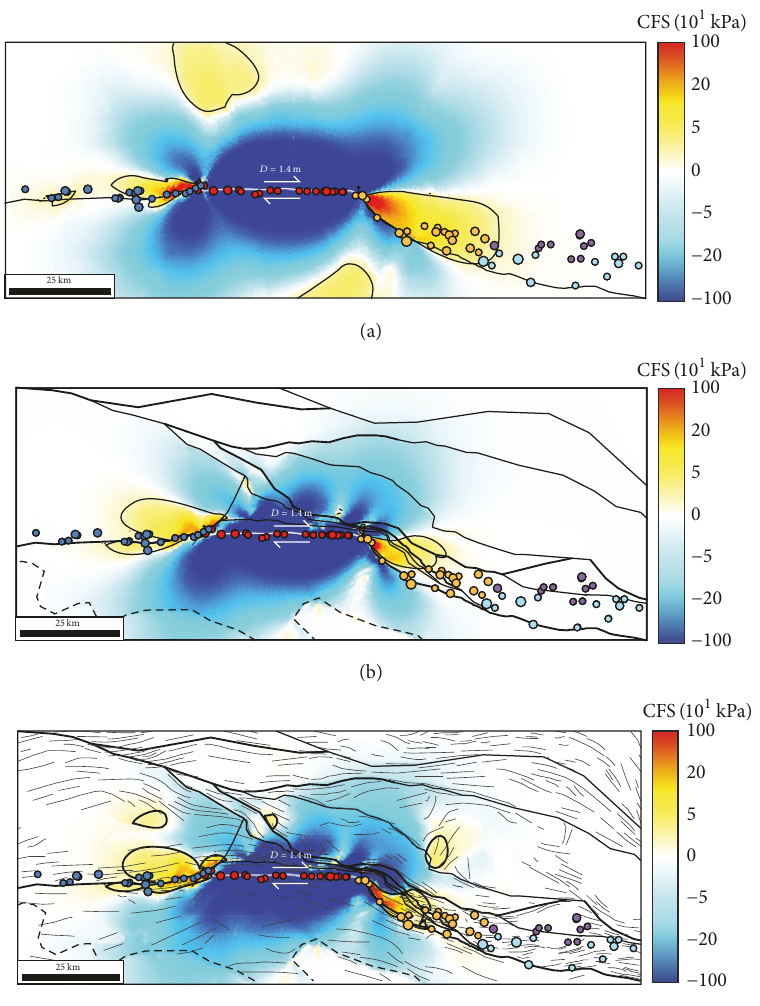
Figure 4: Coulomb static stress changes following the rupture of the Joannes Segment. (a) Model 1.a includes only the Cadillac-Larder Lake Fault. (b) Model 1.b includes rheological contrasts and the structural framework. (c) Model 1.c same as 1.b but with foliation fabric added as low-strength primary failing planes. Positive lobe boundaries are set at 30 kPa. The circles indicate deposits’ locations, with colours reflecting the distinct goldfields as explained in Figure